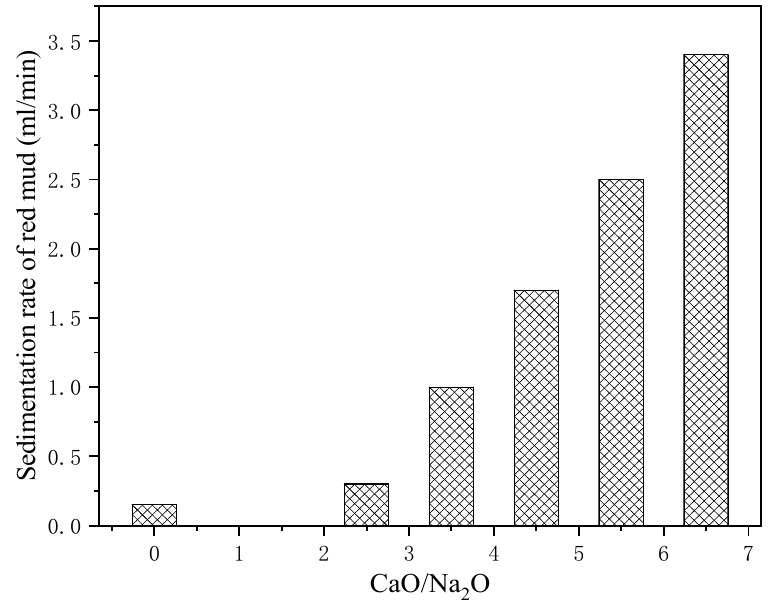
Figure 16. Effect of CaO addition on the sedimentation rate of red mud.